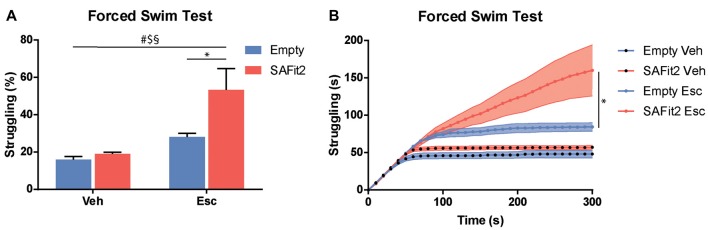
SAFit2 and escitalopram (Esc) treatment strongly affect behavior in the Forced Swim Test (FST). (A) Percentage of time the animals spent struggling in the FST was significantly increased by both SAFit2, as well as Esc treatment. When both drugs were combined, animals spent more than 50% of the time actively trying to escape the water. (B) When looking at the time course of the 5-min experiment, it becomes apparent that animals with a SAFit2 pre-treatment struggled significantly more in the last 3 min of the FST. #Main Esc effect, $main SAFit2 effect, §Esc–SAFit2 interaction effect, *significant post hoc effect at p < 0.05.